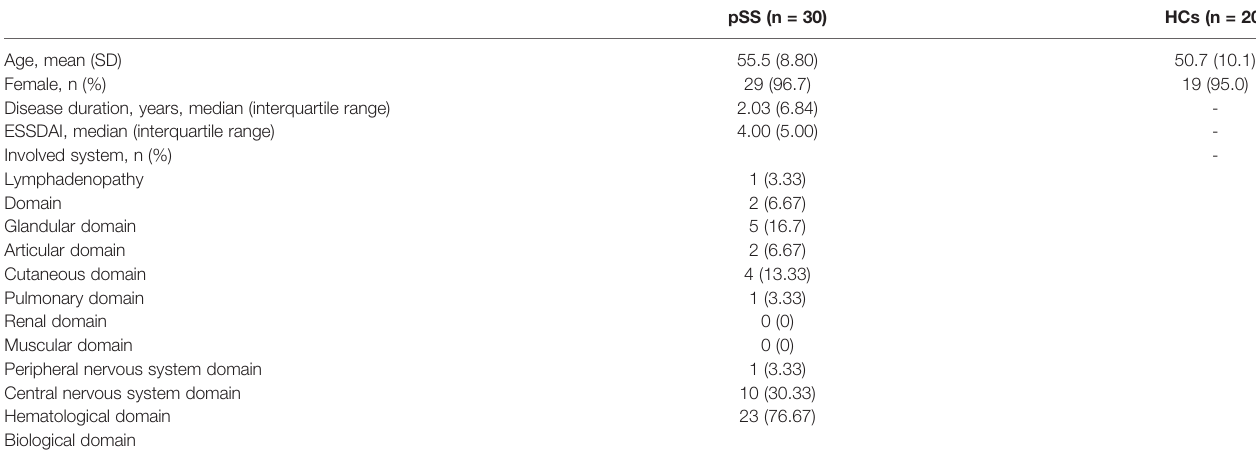
TABLE 1 | Demographic and clinical characteristics of the study